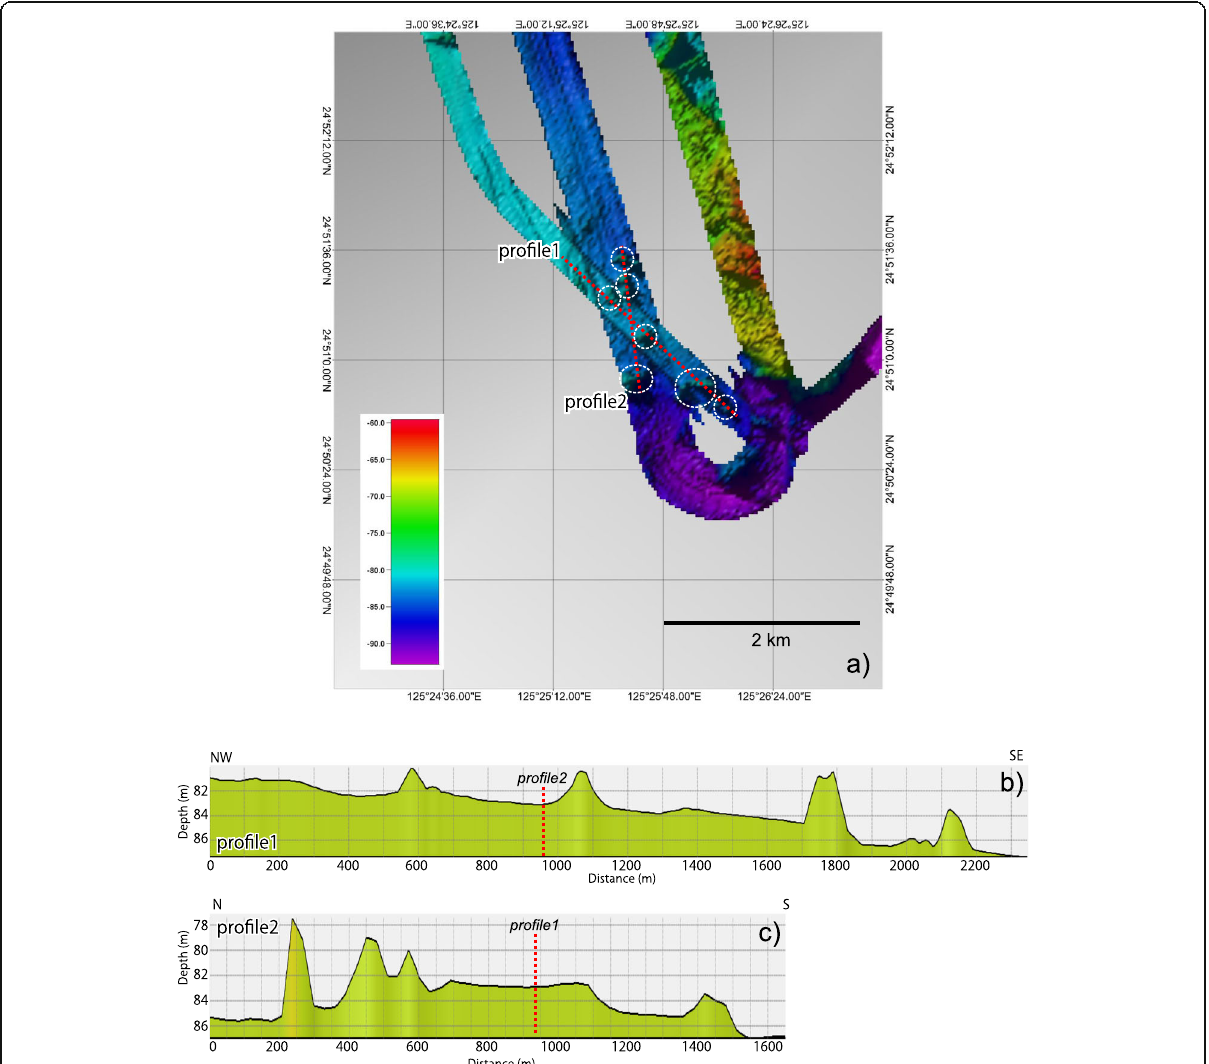
Fig. 6 MBES topography off eastern Miyako-jima. The red lines on the map show the cross-section locations. a Submarine topographic relief data obtained by MBES. Broken red lines indicate the location of profiles ( b , c ). The broken white circles indicate the mound-shaped structures. b Profile 1: NW-SE topographic profile. c Profile 2: N-S topographic